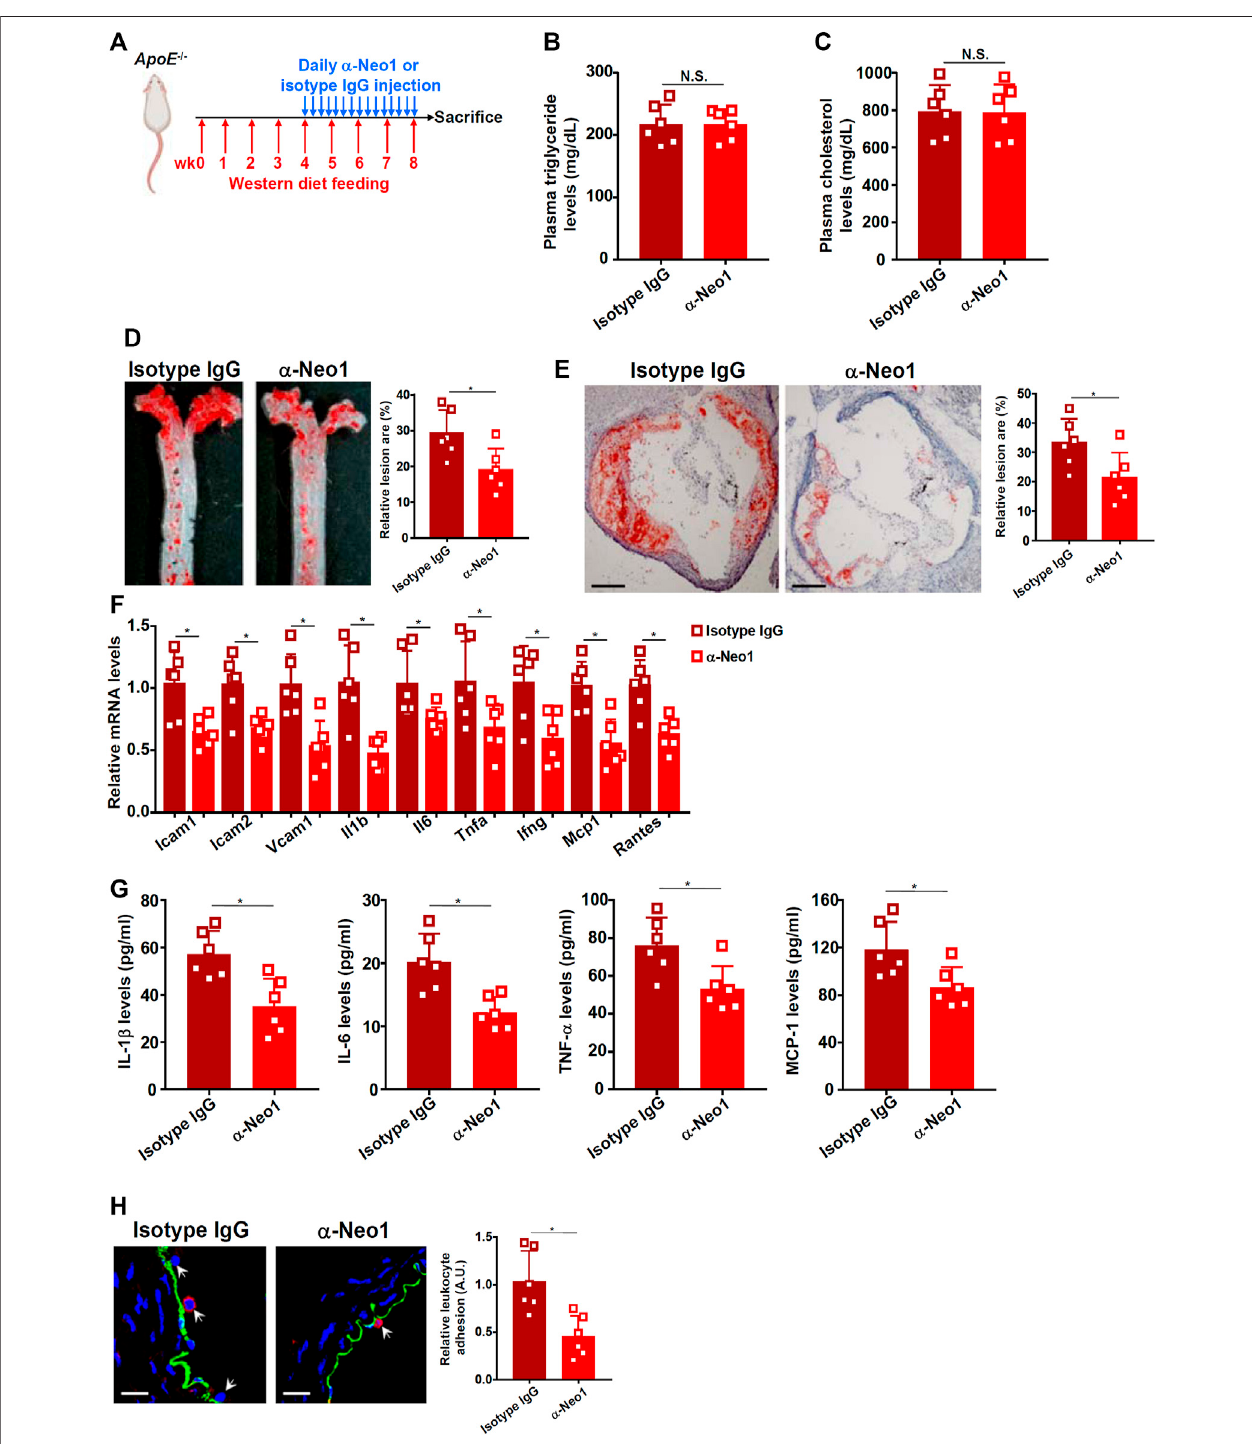
FIGURE4 | Neo-1 inhibition attenuates atherosclerosis in mice. (A) Scheme ofanimalprotocol. (B) Plasma triglyceride levels. (C) Plasma cholesterollevels. (D) Oil redOstainingofthethoracicaorta. (E) OilredOstainingoftheaorticsinus. (F) GeneexpressioninaorticarterieswasexaminedbyqPCR. (G) Levelsofpro-in fl ammatory mediatorswereexaminedbyELISA. (H) In fi ltration ofmacrophages wasexaminedbyimmuno fl uorescence staining. N =6miceforeach group. ErrorbarsrepresentSD (* p < .05, one-way ANOVA).